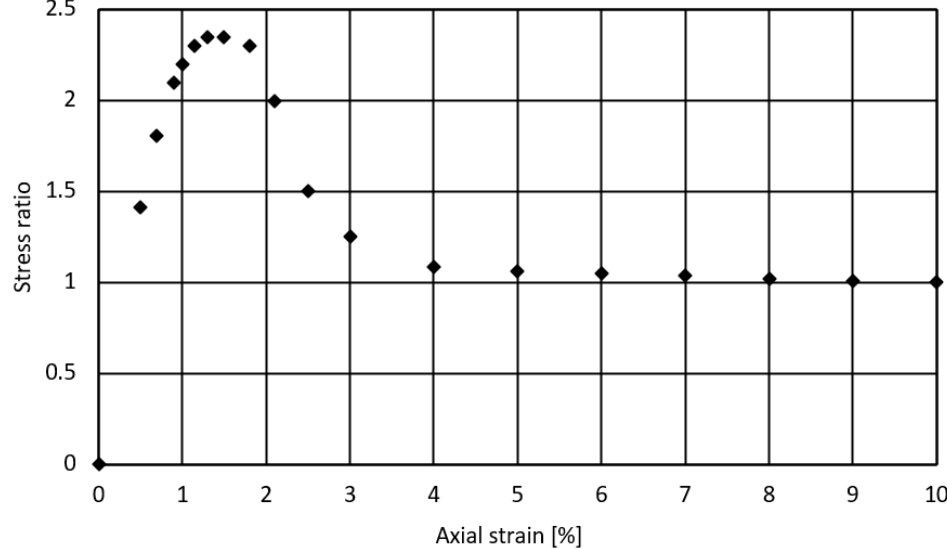
Figure 8. The variation of stress ratio vs. axial strain.